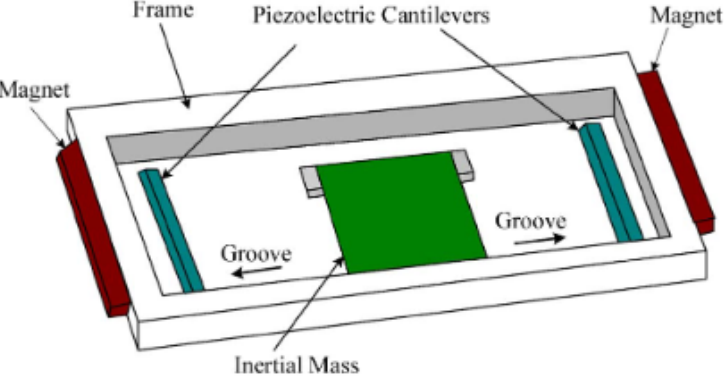
Figure 7. Structure of Piezoelectric Vibration EH